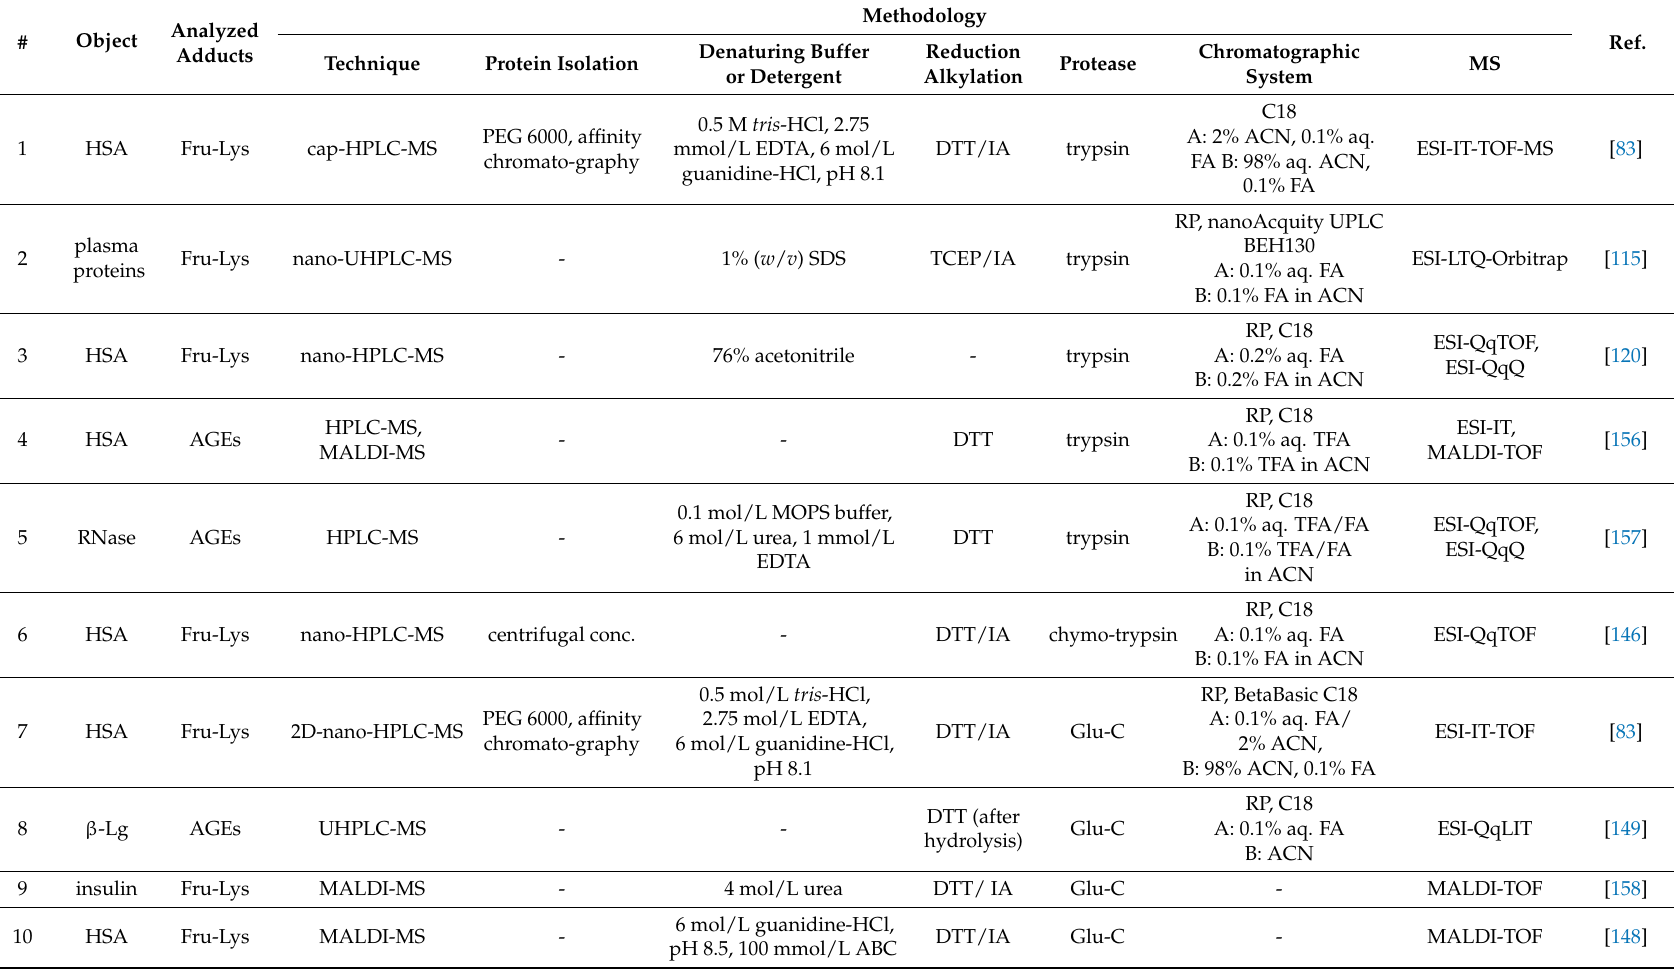
Table 1. Digestion strategies used in analysis of protein